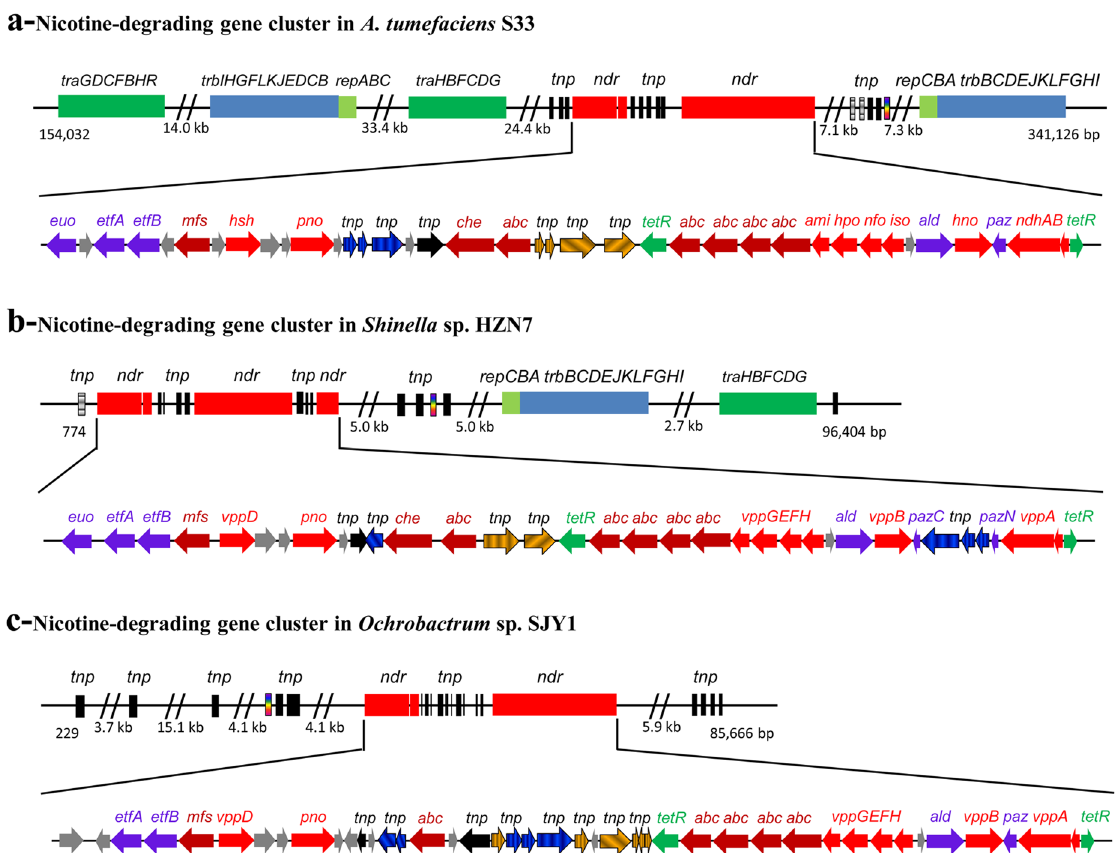
Figure 3. The genetic organization of the gene cluster involved in the hybrid nicotine-degrading pathway in A . tumefaciens S33, Shinella sp. HZN7 and Ochrobactrum sp. SJY1. The gene modules of traGDCFBHR and trbIHGFLKJEDCB encode conjugal transfer proteins; repABC encode plasmid partitioning and replication initiation proteins. ndr , nicotine-degrading gene cluster; tnp , transposase; euo , electron transfer flavoprotein-ubiquinone oxidoreductase; etfAB , electron transfer flavoprotein subunit alpha and beta; mfs , major facilitator superfamily transporter; hsh ( vppD ), 6-hydroxy-3-succinoyl-pyridine hydroxylase; pno , 6-hydroxypseudooxynicotine oxidase; che , chemotaxis protein; abc , ABC transporter; tetR , TetR family transcriptional regulator; ami ( vppG ), maleamate amidohydrolase (amidase); hpo ( vppE ), 2,5-dihydroxypyridine dioxygenase; nfo ( vppF ), N -formylmaleamate deformylase; iso ( vppH ), maleate cis/trans- isomerase; ald , aldehyde dehydrogenase; hno ( vppB ), 6-hydroxynicotine oxidase; paz , pseudoazurin; ndhAB ( vppA ), nicotine